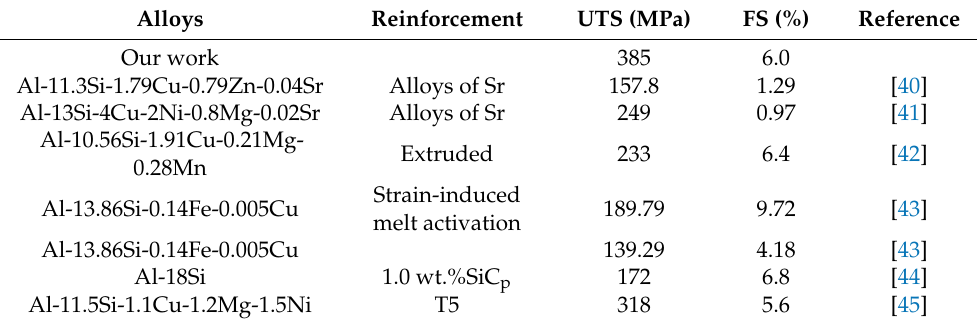
Table 5. Comparison of different strengthening methods in this work for Al